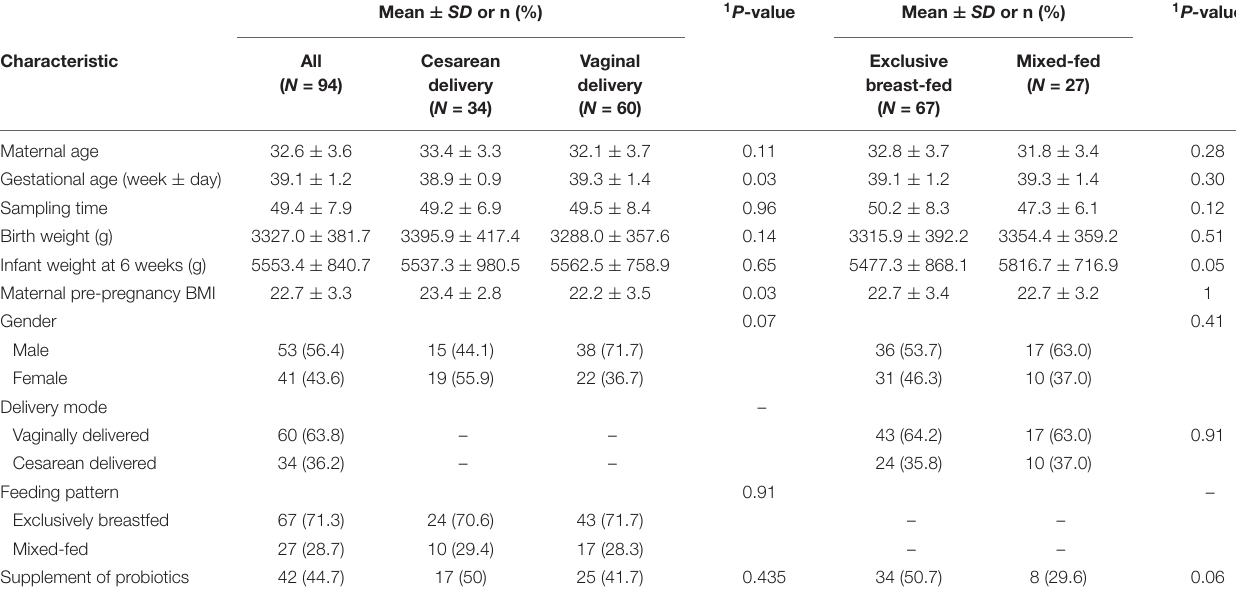
TABLE 2 | Characteristics of infants by delivery mode and feeding pattern ( n = 94).